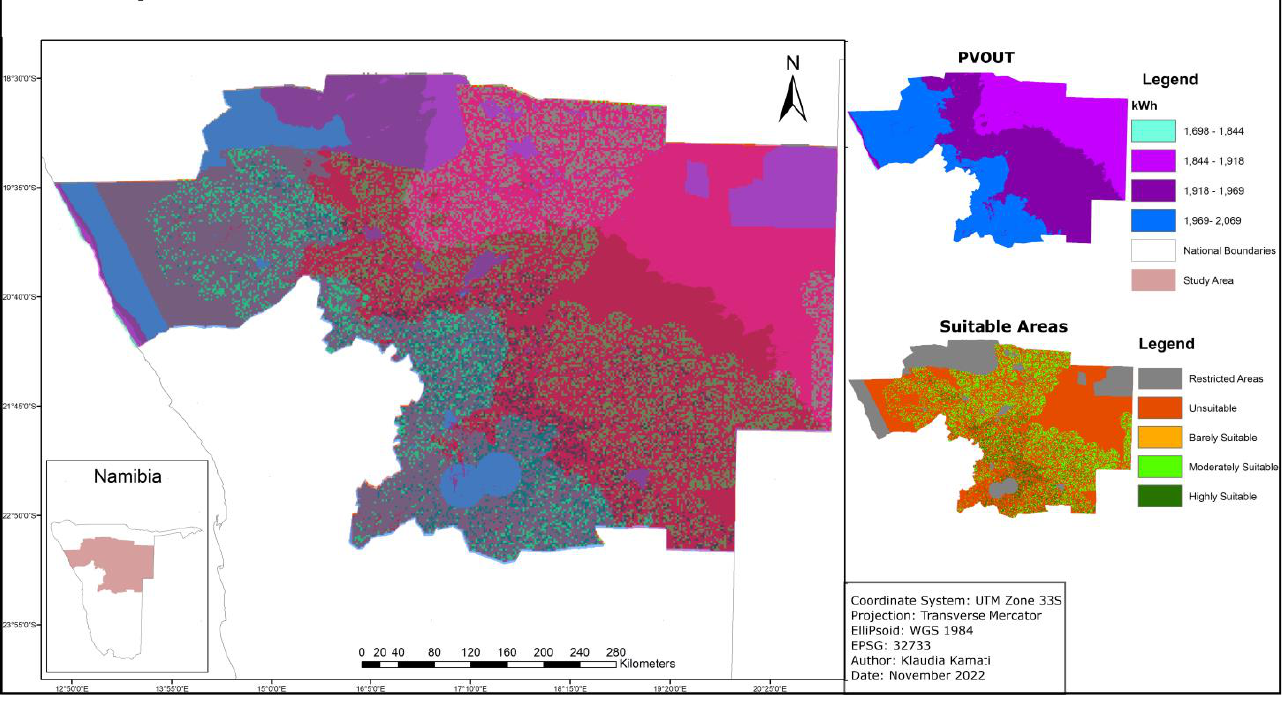
Figure 11. Validation of solar site suitability results. Table 9. Area overlapped between the World Bank study and this study.